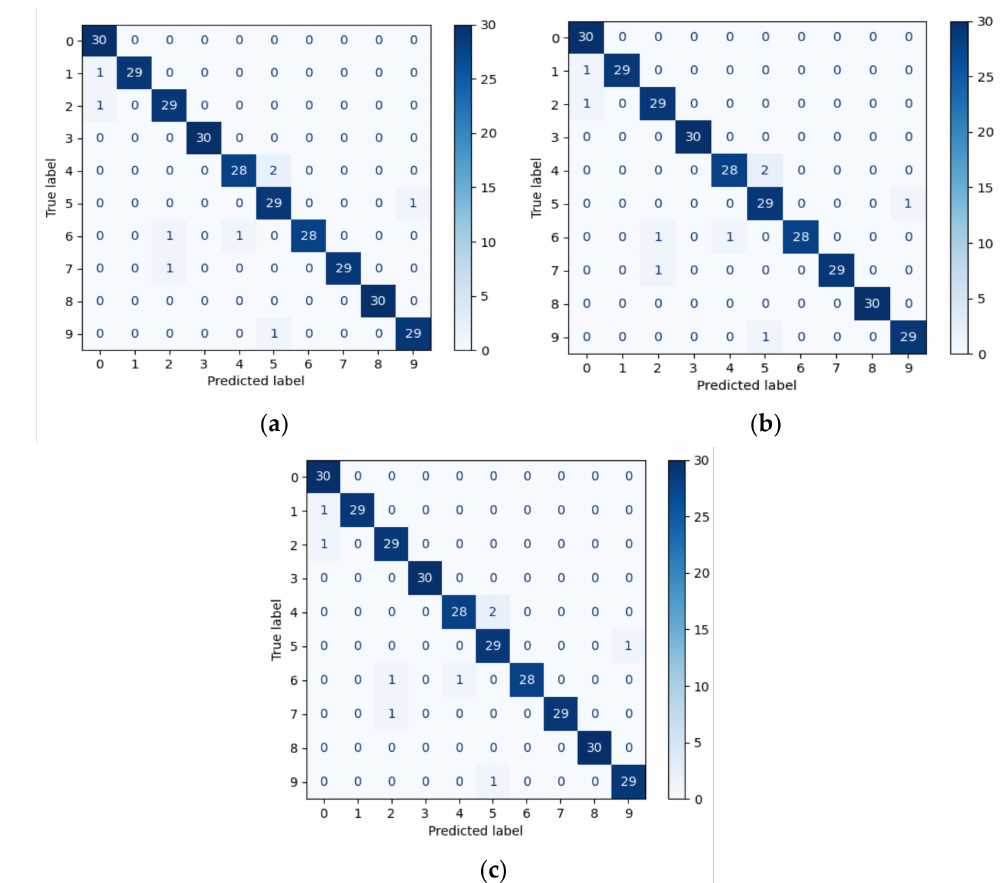
Figure 6. Confusion matrix of the models introduced with ten features: ( a ) trained used Dataset 1; ( b ) trained using Dataset 2; ( c ) trained using Dataset 3.